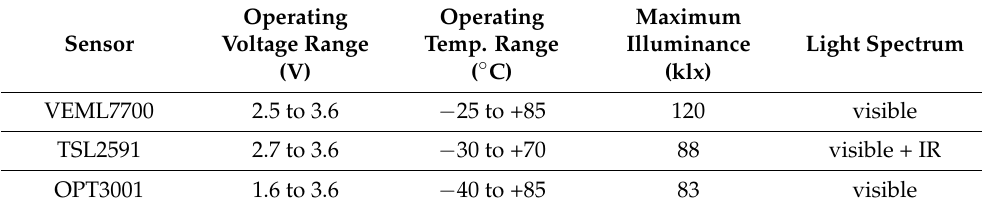
Table 2. Low-cost illuminance sensor modules.